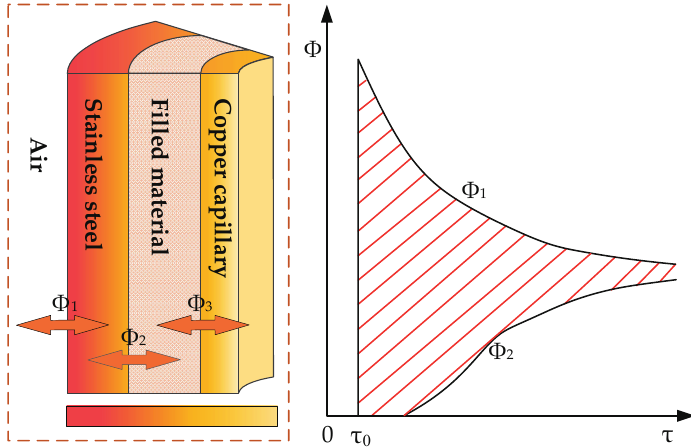
Figure 4. The amount of heat conduction on both sides of the cylinder with time during the process of transient heat